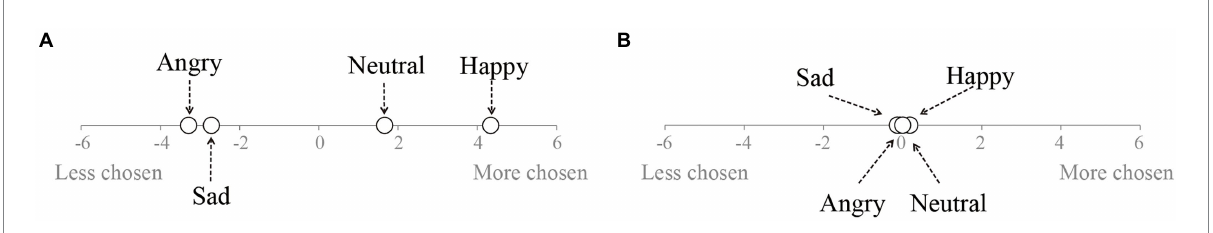
FIGURE 2 Results of experiment 1: Who is the best to be with? Mean of the grade on the scale in partner judgments with 500 ms presentation (A) and 5 s presentation (B) .